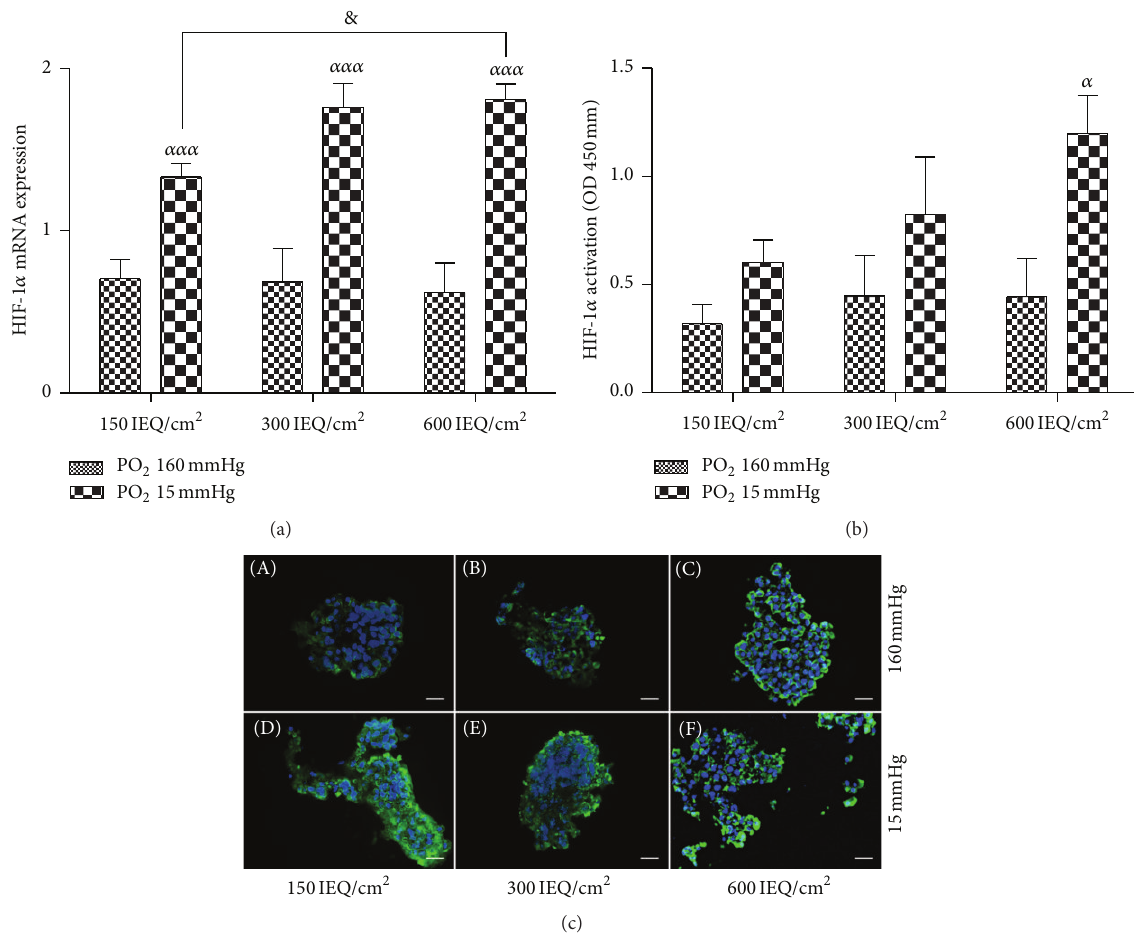
Figure 2: Hypoxia marker expression. (a) Levels of hypoxia-inducible factor 1 alpha (HIF-1 𝛼 ) mRNA expression after 24 hours in culture under normoxia (PO 2 160mmHg) and hypoxia (PO 2 15 mmHg) at 150, 300, and 600 IEQ/cm 2 . (b) Translocation and activation of HIF- 1 𝛼 protein were performed after 24 hours in each density (150, 300, and 600 IEQ/cm 2 ) under normoxia and hypoxia conditions. (c) Representative images of hypoxyprobe stained cells at 150, 300, and 600 IEQ/cm 2 under normoxia and hypoxia. Blue staining highlights the cell nuclei (DAPI), and the green staining indicates pimonidazole (hypoxia marker) expression. Scale bars = 50 𝜇 m. 𝛼𝛼𝛼 𝑝 < 0.001 compared to the same concentration under normoxic conditions, & 𝑝 < 0.05 compared to 150IEQ/cm 2 under hypoxic conditions, and 𝛼 𝑝 < 0.05 compared to the